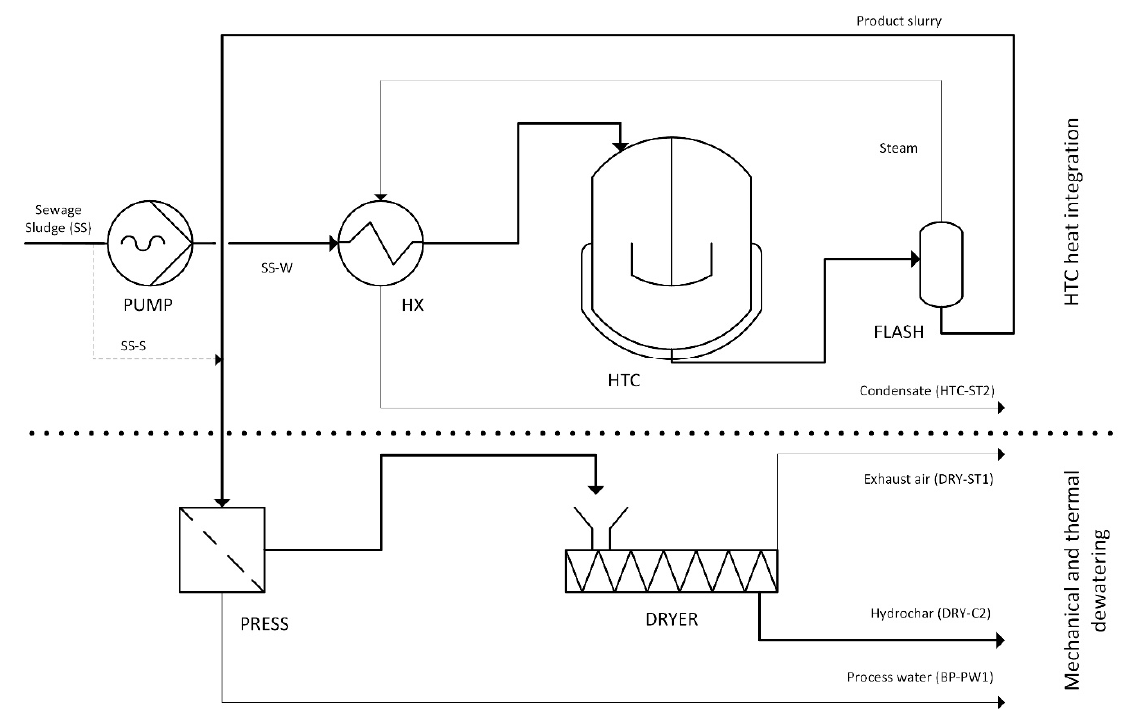
Figure 2. Flowsheet of the modeled hydrothermal carbonization (HTC) process with pre-heating and subsequent mechanical dewatering and thermal drying. ( HX = heat exchanger, SS - W = water content of sewage sludge, SS - S = solids content of sewage sludge).